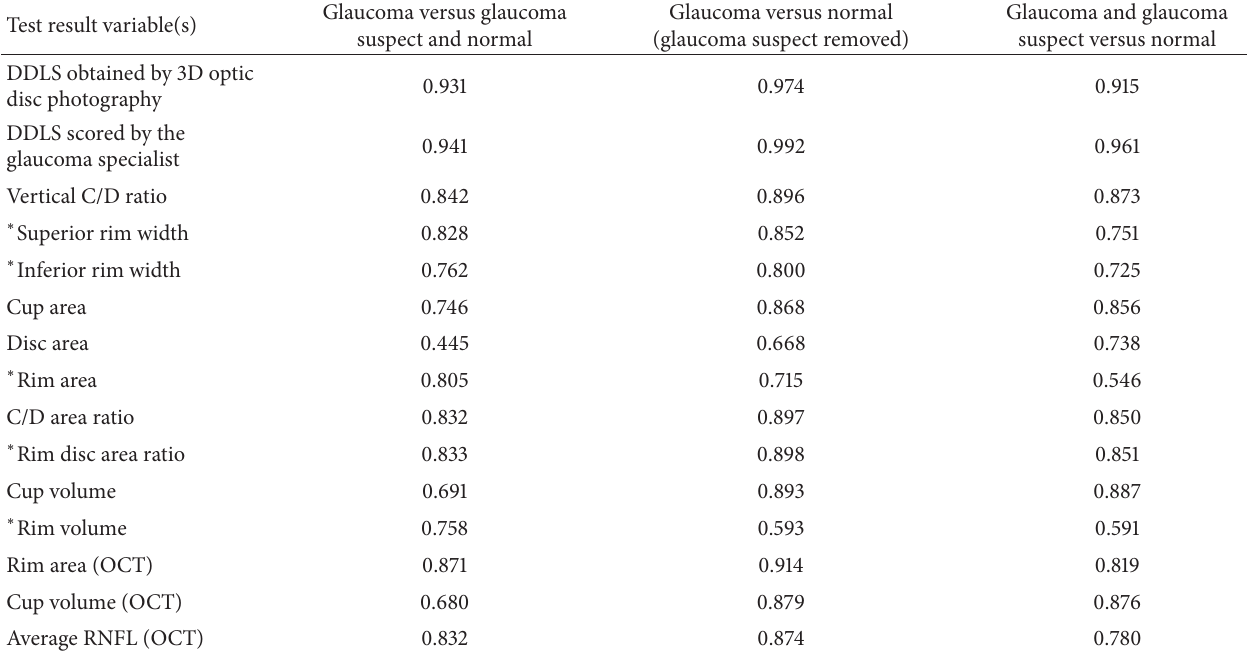
Table 4: Calculation of the area under the curve for each parameter according to group